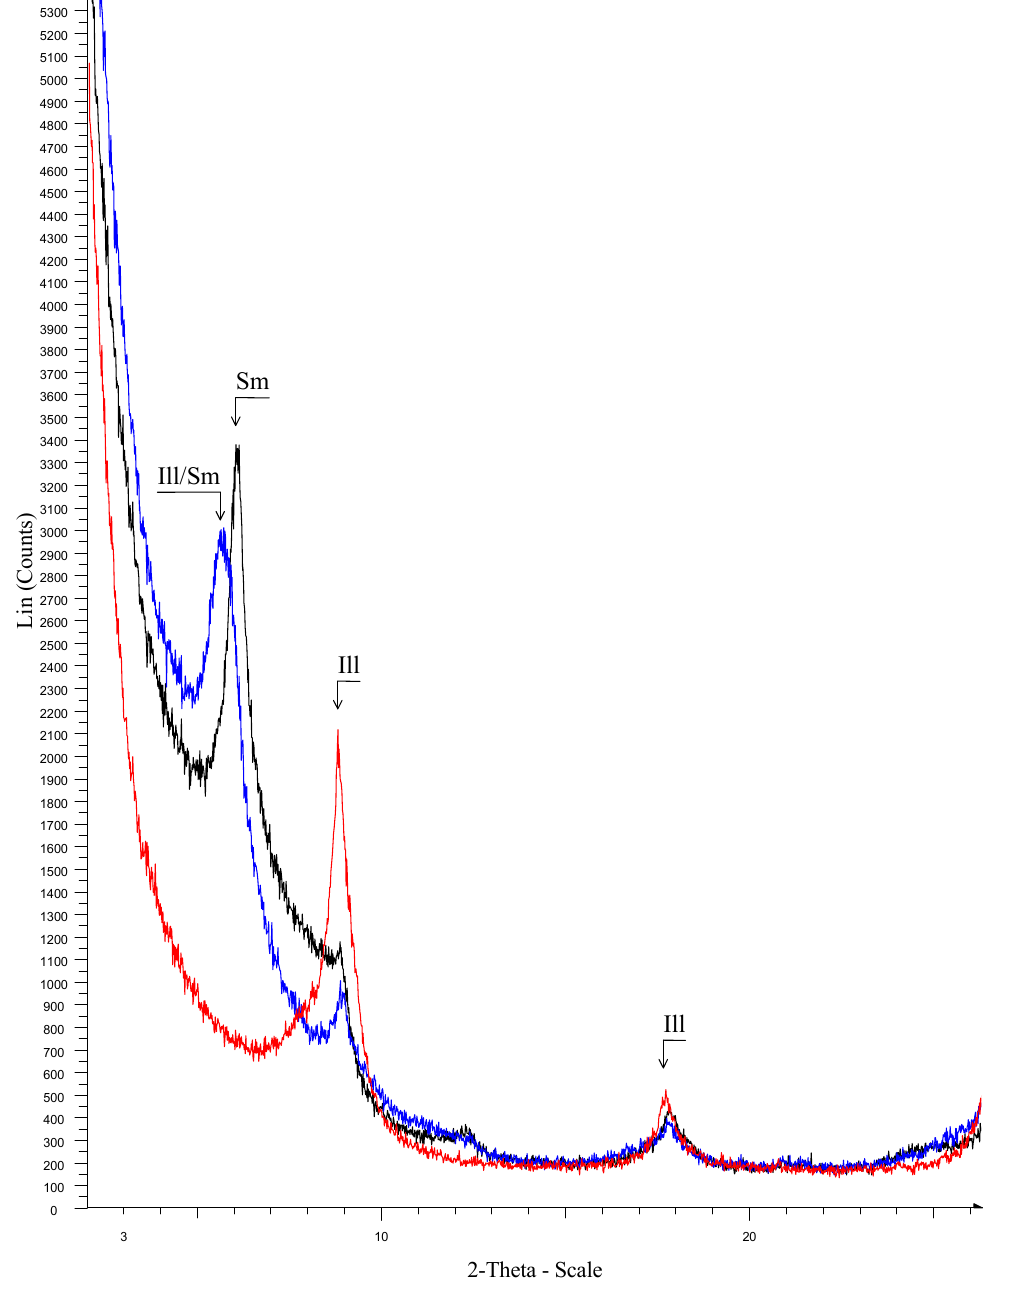
Figure A5. Representative composite diffractogram of the smectite clayey raw materials established according to the clay mineral content revealed from the <2 μ m fraction. The diffraction pattern of each preparation is intentionally equally displaced in respect to Y axis to obtain a better visual. Ab- breviations: Sm = Smectite, Ill = Illite, Ill/Sm = Illite/Smectite. Red line = heated at 490 °C; Blue line = ethylene-glycol solvation; Black line = air dried.